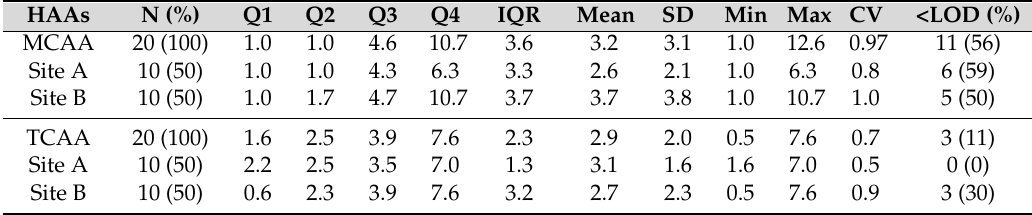
Table 2. Measured concentrations (in µ g/L) of HAAs in urine specimens.